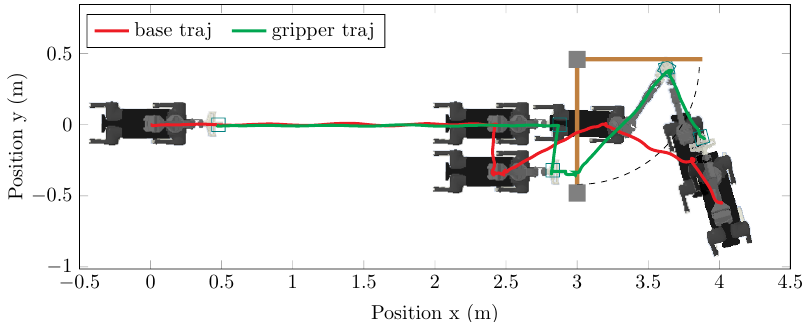
Figure 10. Top view of base and gripper trajectories during opening and walking through a spring- loaded door. The red line represents the robot base trajectory, the green line indicates the gripper trajectory, and the brown line denotes the door position.